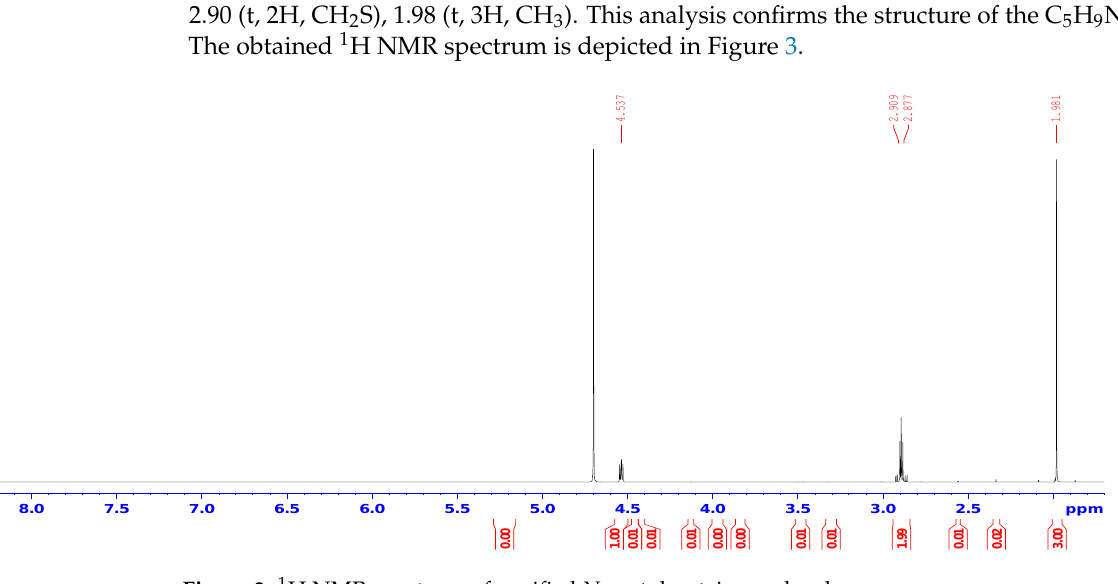
Figure 2. The schematic of three-step isolation process of N -acetylcysteine.